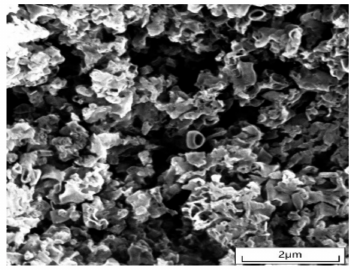
Figure 2. SEM image of g-C 3 N 4